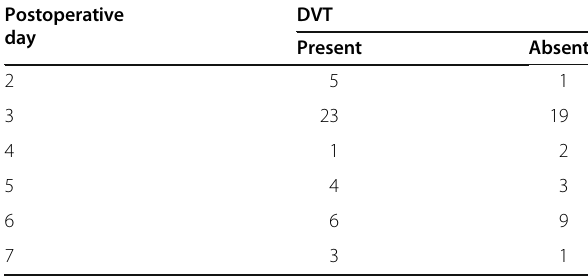
Table 2 The number of patients in whom DVT was detected and not detected on US performed in different postoperative days